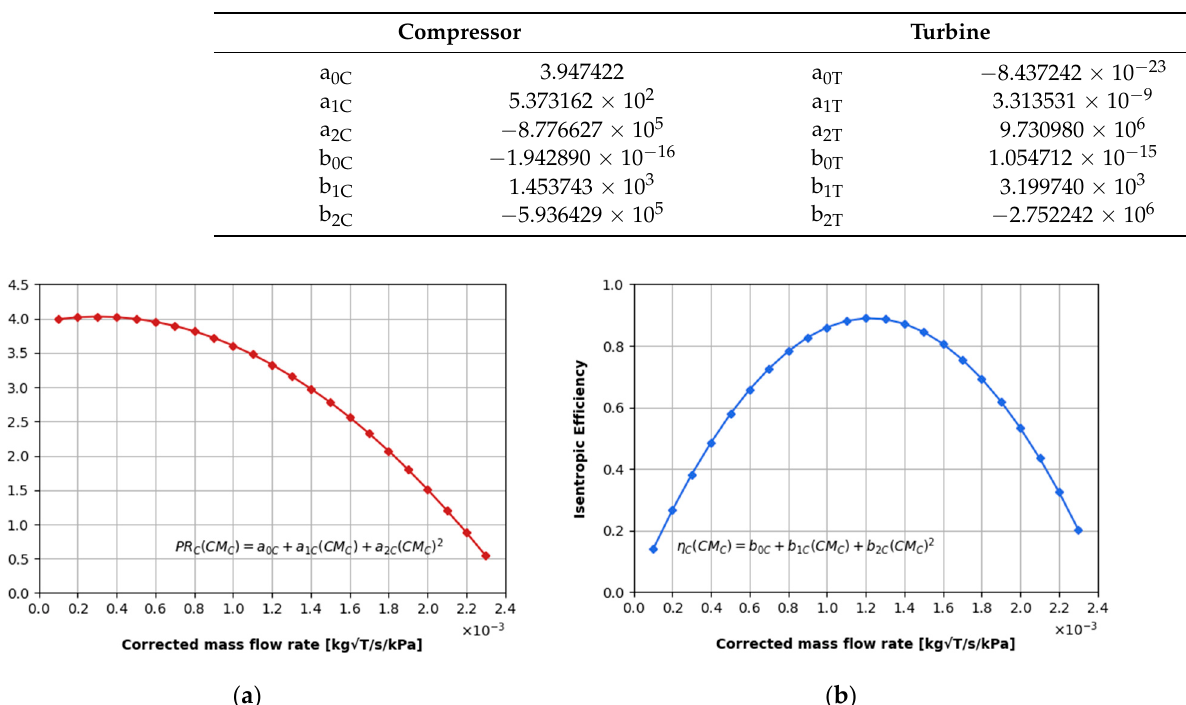
Figure 6. ( a ) Pressure ratio vs. corrected mass flow rate for the compressor; ( b ) Isentropic efficiency vs. corrected mass flow rate for the compressor.